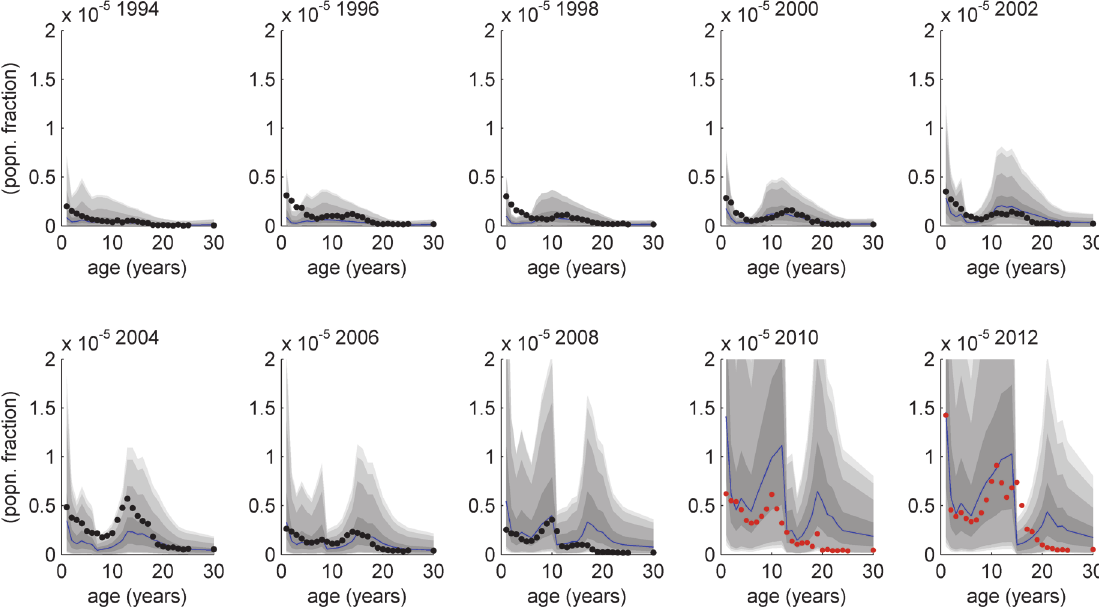
Fig 3. Cross-sectional incidence of disease over age of population. Annual age-dependent (to age 30 years) incidence of pertussis disease cases for the years 1994 – 2012 in 2 year intervals. Gray shaded envelopes indicate 50%, 90%, 95%, and 99% credible intervals from the model parameter and uncertainty estimation. Black points (1994 – 2008) indicate disease incidence data collected by the NNDSS. The red crosses on the 2010 and 2012 plots also represent NNDSS incidence data; however, the model was not fitted to these data and so model outputs represent out-of-sample predicted age-dependent incidence